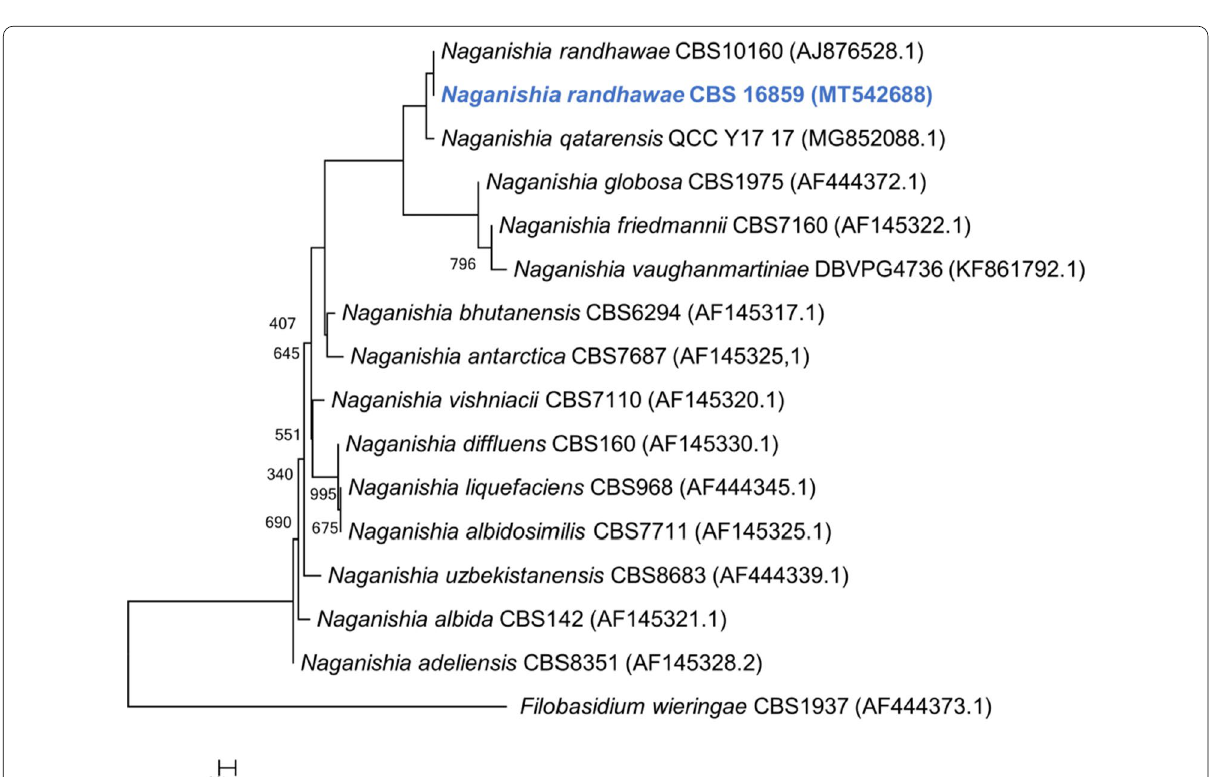
Fig. 6 Maximum likelihood (ML) phylogeny indicating the taxonomic placement of Naganishia randhawae CBS 16859. The tree was constructed on the basis of the internal transcribed spacer region sequences using PhyML-SMS, with the best fit evolutionary model HKY85 2010; Lefort et al. 2017). Bootstrap support values ( n 1000 replicates) greater than 500 are indicated at the =